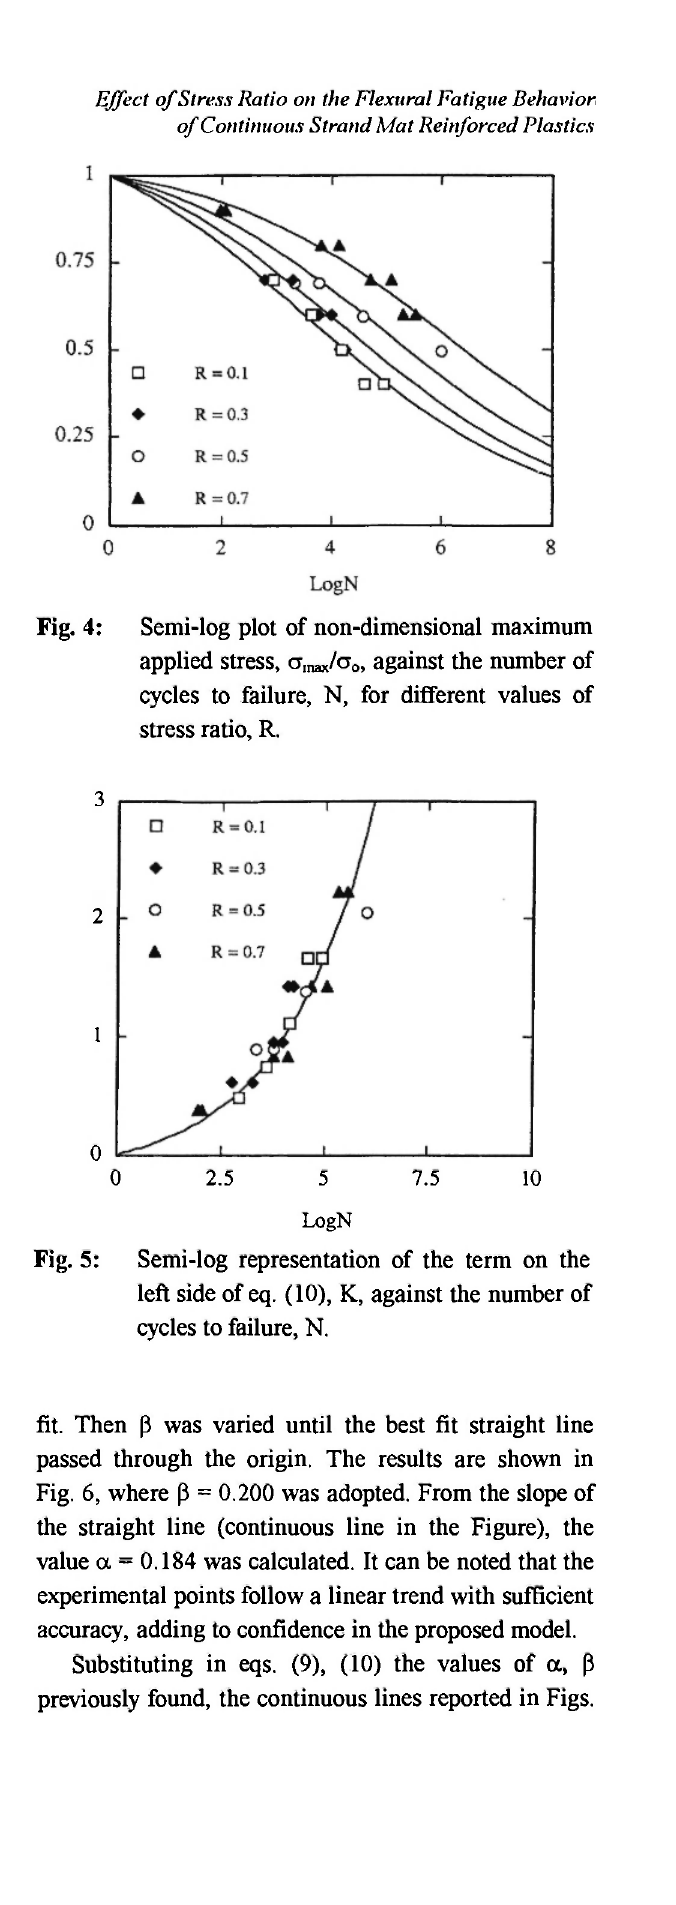
Fig. 5: Semi-log representation of the term on the left side of eq. (10), K, against the number of cycles to failure,